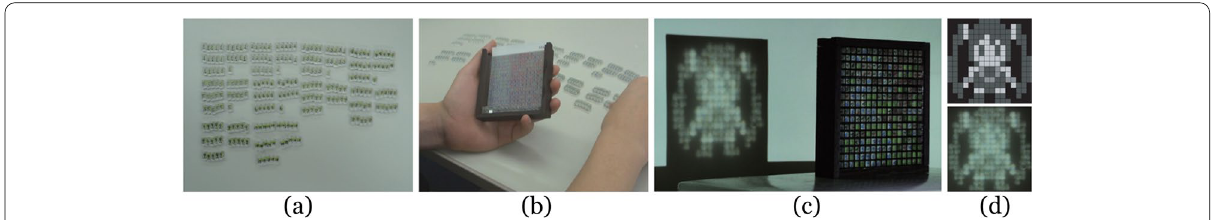
Fig. 24 a Yue et al.[67] pre‑prepared a fixed number and variety of sticks for the user; b Based on the input image, their algorithm automatically generates the arrangement of the sticks, and the user needs to manually assemble the sticks according to the results; c Once assembled, the device refracts light into the input image; d Top: the input image; bottom: the image on the screen